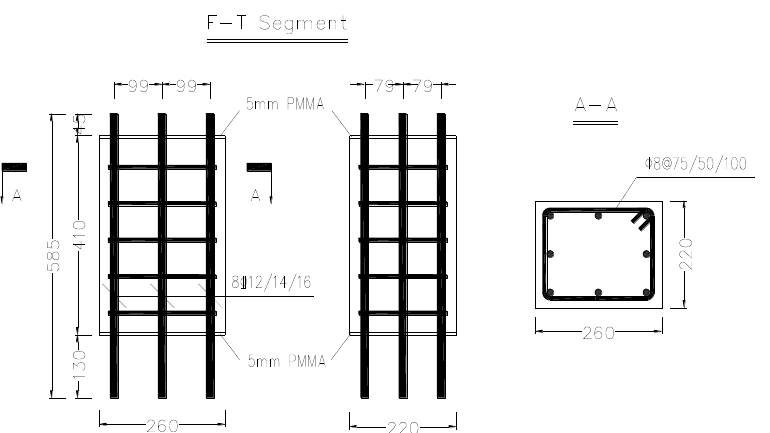
Figure 6. The dimensions and reinforcement details of the freeze – thaw segments (unit: mm) .